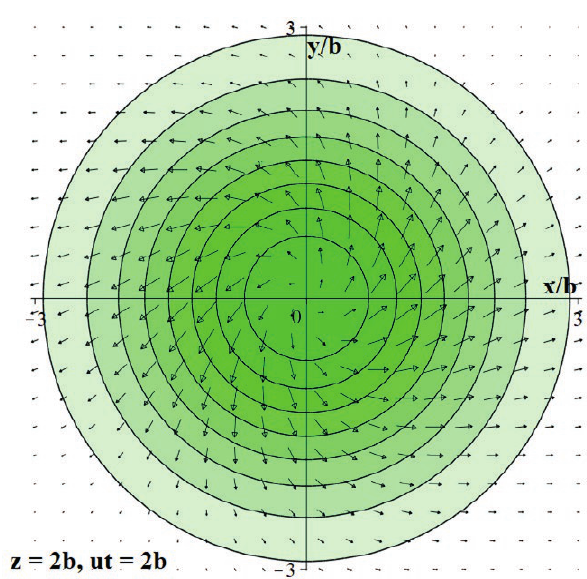
Figure 2. Gaussian spinor wavepacket, at z = ut =2 b . The trans- verse current density now has radial and azimuthal components. The group speed is u , so the section is through the centre of the wavepacket. The longitudinal current density is not